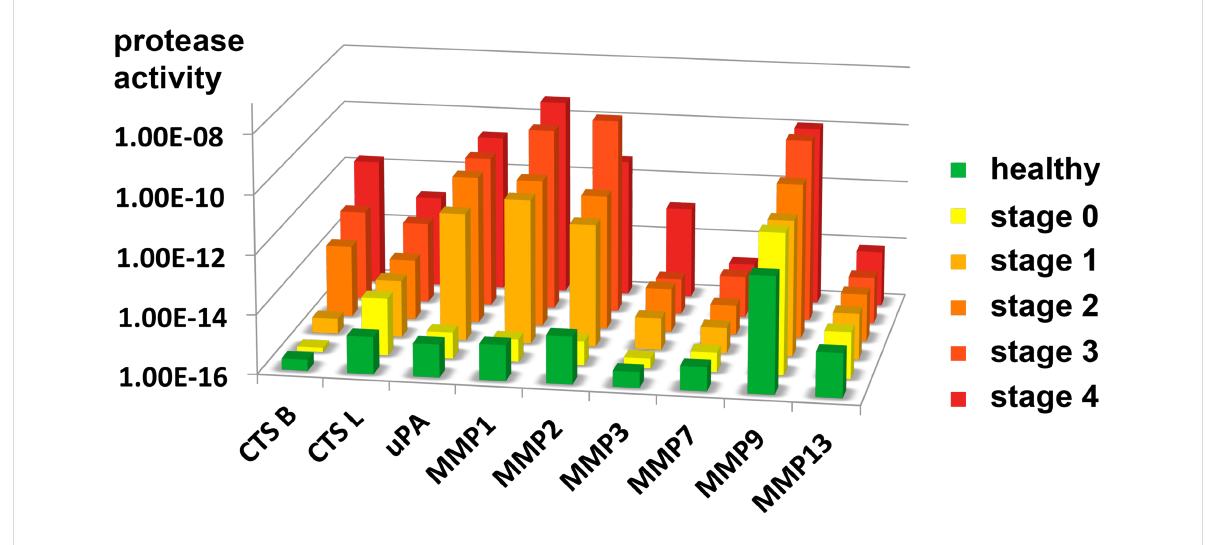
Figure 9: Average protease activity as a function of breast cancer stage/healthy control group for all nine proteases monitored in this study. Note that the activity is shown on a logarithmic scale (log 10 (protease activity)). The data summarized in this figure is also reported in Supporting Information File 1, Tables